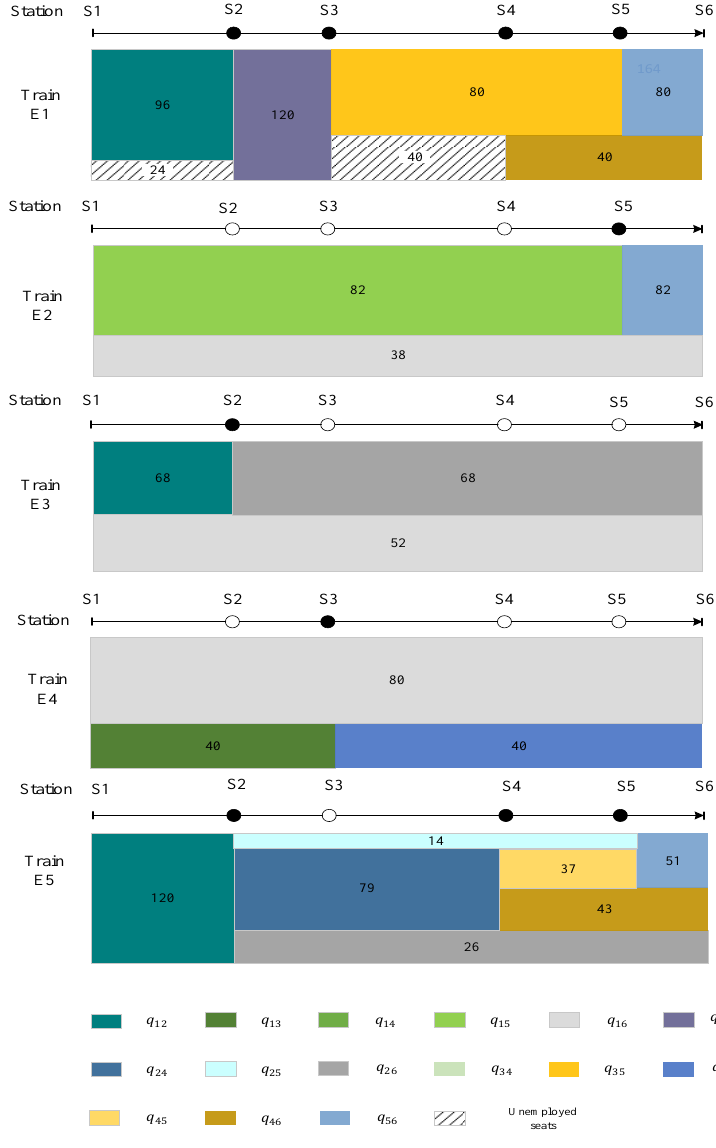
Figure 8. Passenger distribution for existing trains.